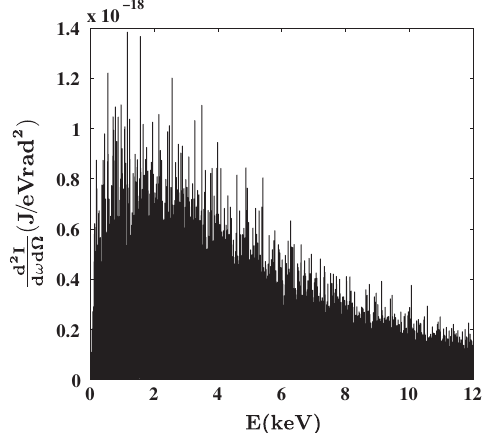
FIG. 3. The spectral intensity per solid angle along the þ y axis radiated by an electron scattering with a circularly polarized laser pulse. All of the calculation parameters are the same as those in Fig. 2.